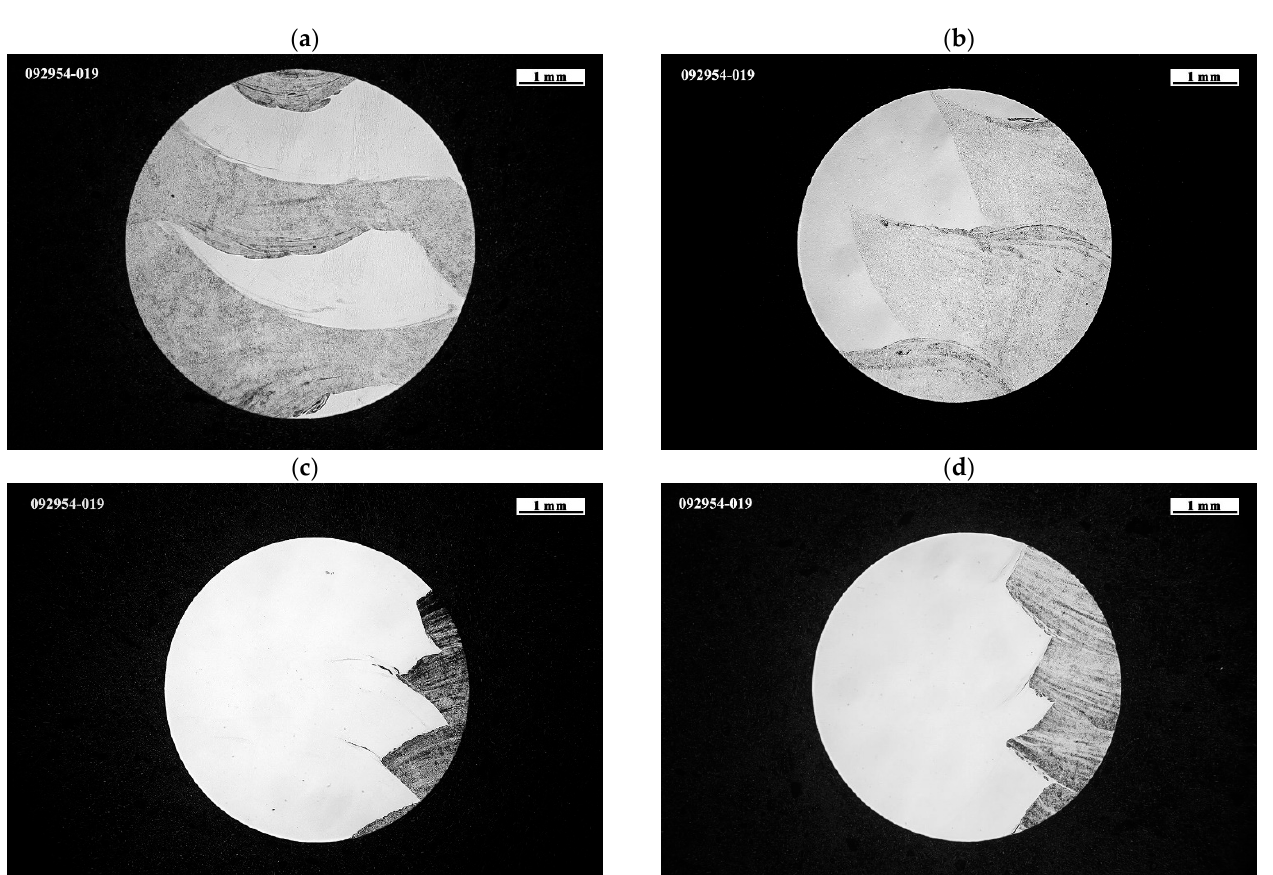
Figure 9. Cross-section of the neck area in the tensile specimens of ( a ) Sample 1, ( b ) Sample 2, ( c ) Sample 3 and ( d ) Sample 4.